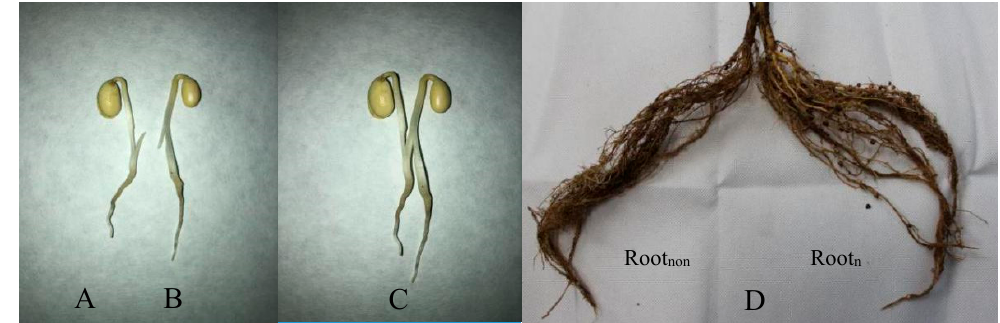
Figure 1. Soybean plant with dual root system. ( A ) Non-nodulated seedling, ( B ) nodulated seedling, ( C ) two seedlings cross-inserted into their cuts and clipped with a grafting clip, and ( D ) roots of a soybean plant with a dual root system at the time of sampling, with non-nodulated roots (Root non ) on the left and nodulated roots (Root n ) on the right side.